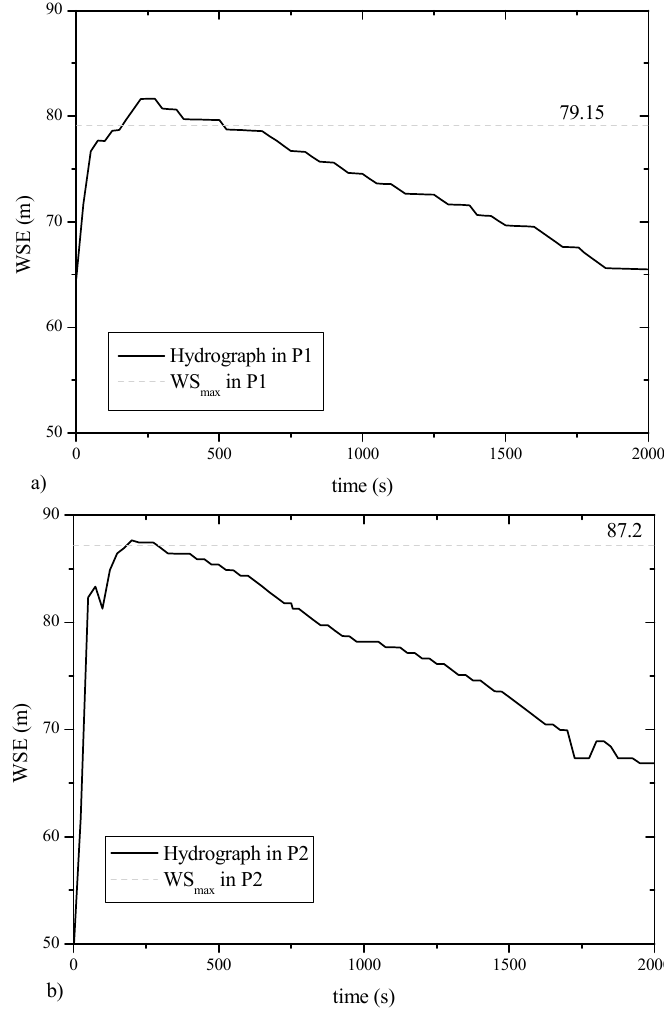
Figure 3. Flood hydrograph (simulated water level against time) at points: P1 ( a ); and P2 ( b ) compared with the maximum level surveyed by the local police after the dam failure (dotted line).